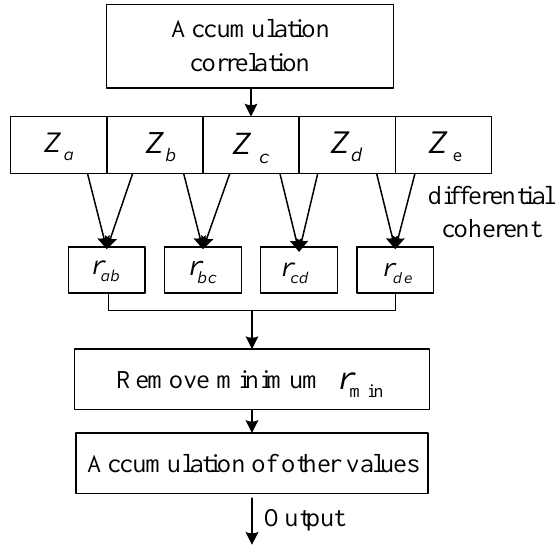
Figure 5. Schematic diagram of bit sign transition estimation.